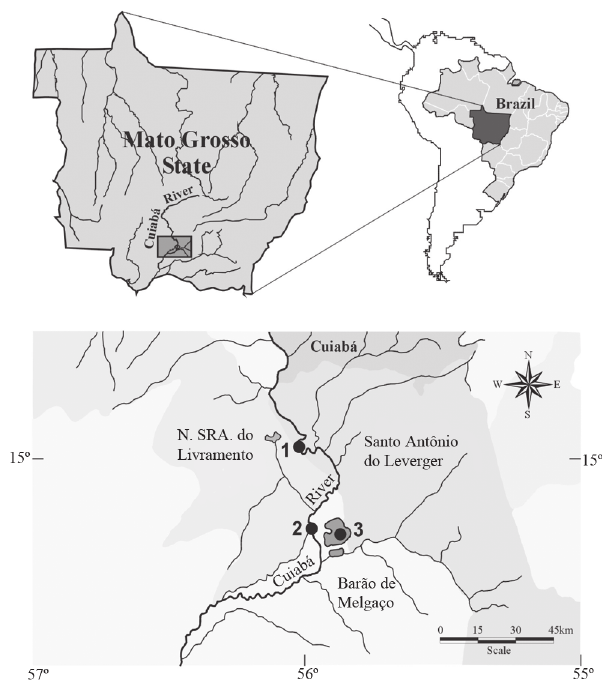
Fig. 1. Location of the sampling site in the Cuiabá River (1 and 2) and Chacororé pond (3), in the upper Pantanal region, Mato Grosso State,